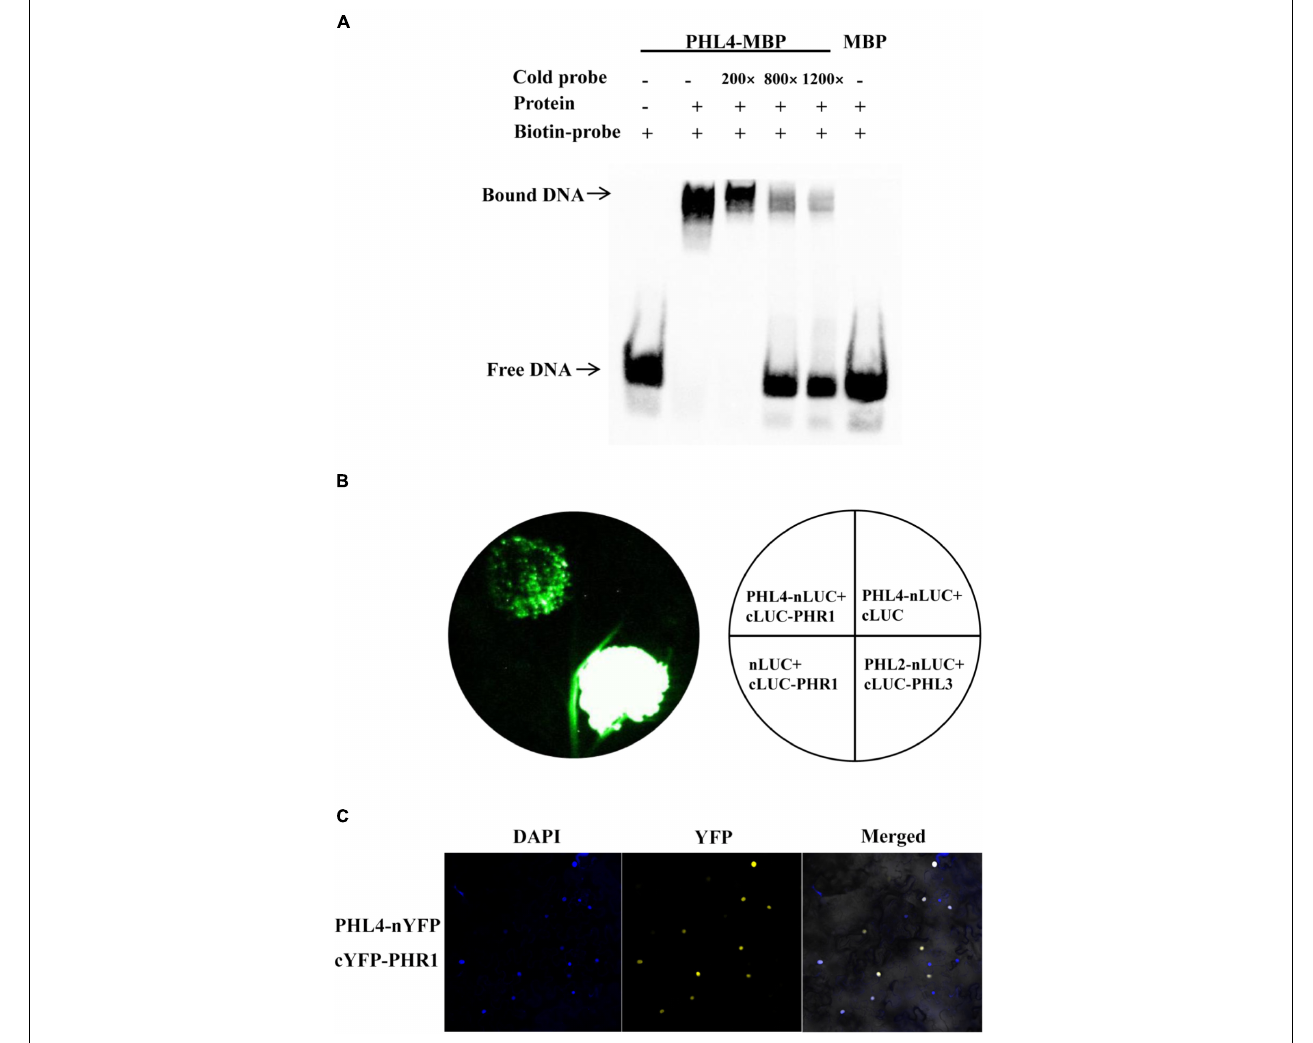
FIGURE 12 | PHL4 binds to the P1BS element and interacts with PHR1. (A) EMSA assay showing that PHL4 protein specifically binds to the P1BS element. The experiment was performed using 4 µ g of MBP-PHL4 protein and 10 fmol of biotin-labeled DNA probe. The same unlabeled probe was used as the competitor at an excess molar ratio of 200:1, 800:1, and 1200:1 to labeled probe. (B) LCI assays for the interaction of PHL4 and PHR1. The constructs PHL4-nLUC and cLUC-PHR1 were co-infiltrated into the leaves of N. benthamiana , and LUC signals were recorded 2 d after infiltration. (C) BiFC assays for the interaction between PHL4 and PHR1. The constructs PHL4-nYFP and cYFP-PHR1 were co-infiltrated into the leaves of N. benthamiana . YFP fluorescence was detected 2 days after infiltration by confocal microscopy. The nuclei were revealed by DAPI